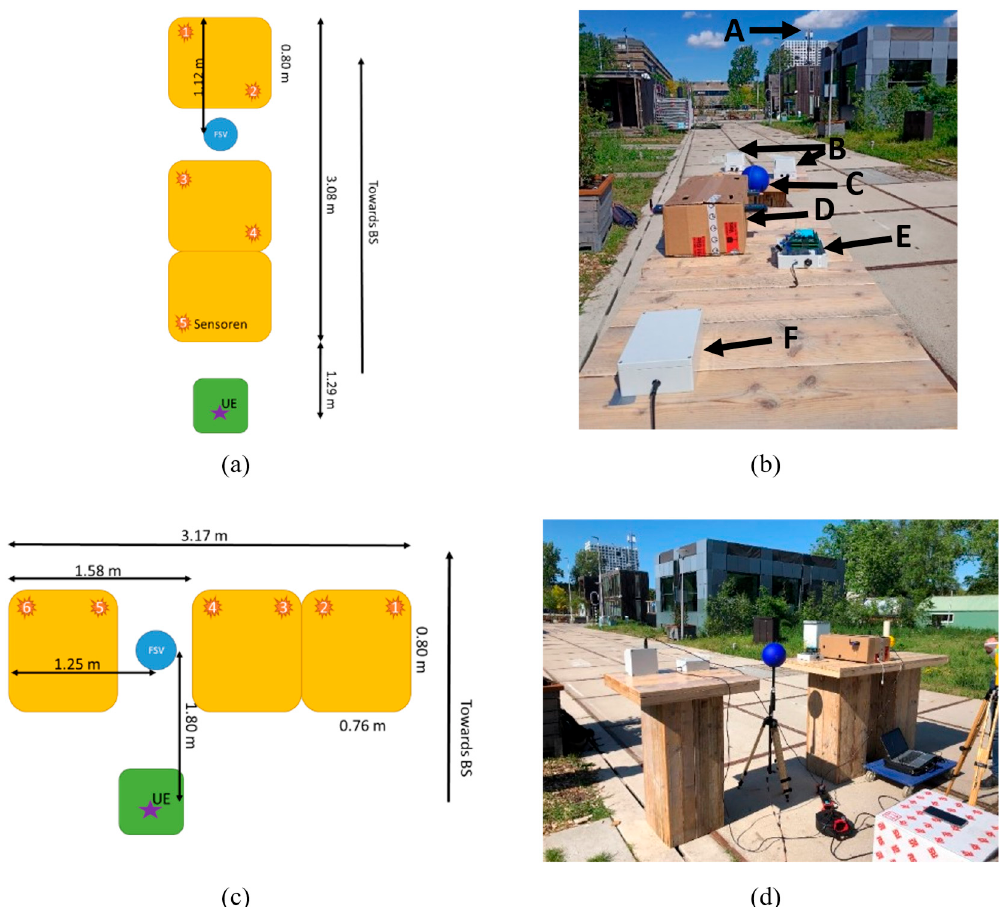
Figure 3. Overview of the in-situ Green Village setup. ( a ) gives an overview of the vertical config- uration, ( b ) shows the real-life setup of ( a ). ( c ) shows an overview of the horizontal configuration, ( d ) shows the real-life setup ( c ). A: Base station antenna; B: WAVES sensors; C: FSV; D: SDRs combined in box (not included in this work due to wrong settings of SDRs); E: S 3 R sensor; F: SDR